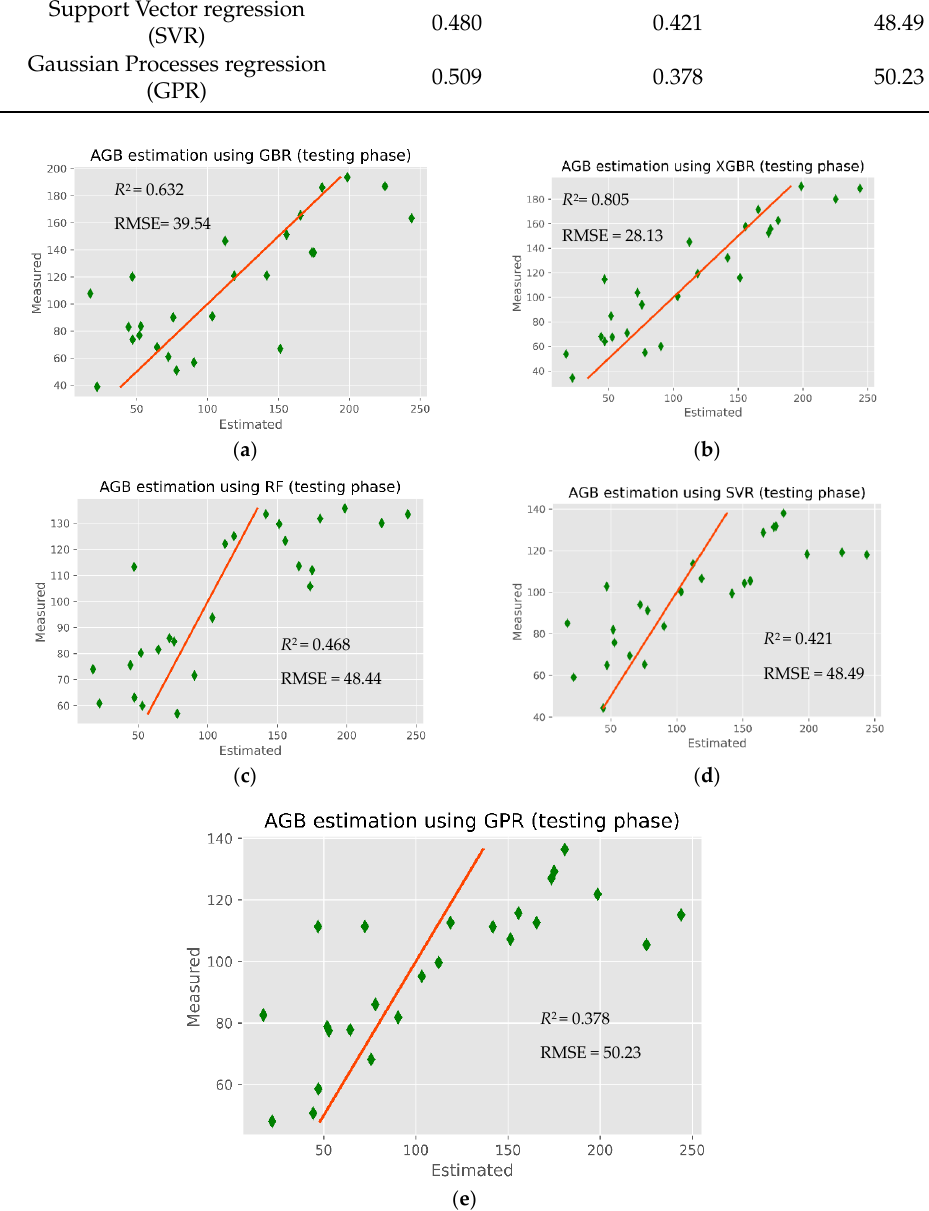
Figure 5. Scatter plots of the estimated (X axis) versus the measured (Y axis) mangrove AGB in the five ML models, integrating the data of S-2, ALOS-2 PALSAR-2, and VIs in the testing phase. ( a ) GBR,